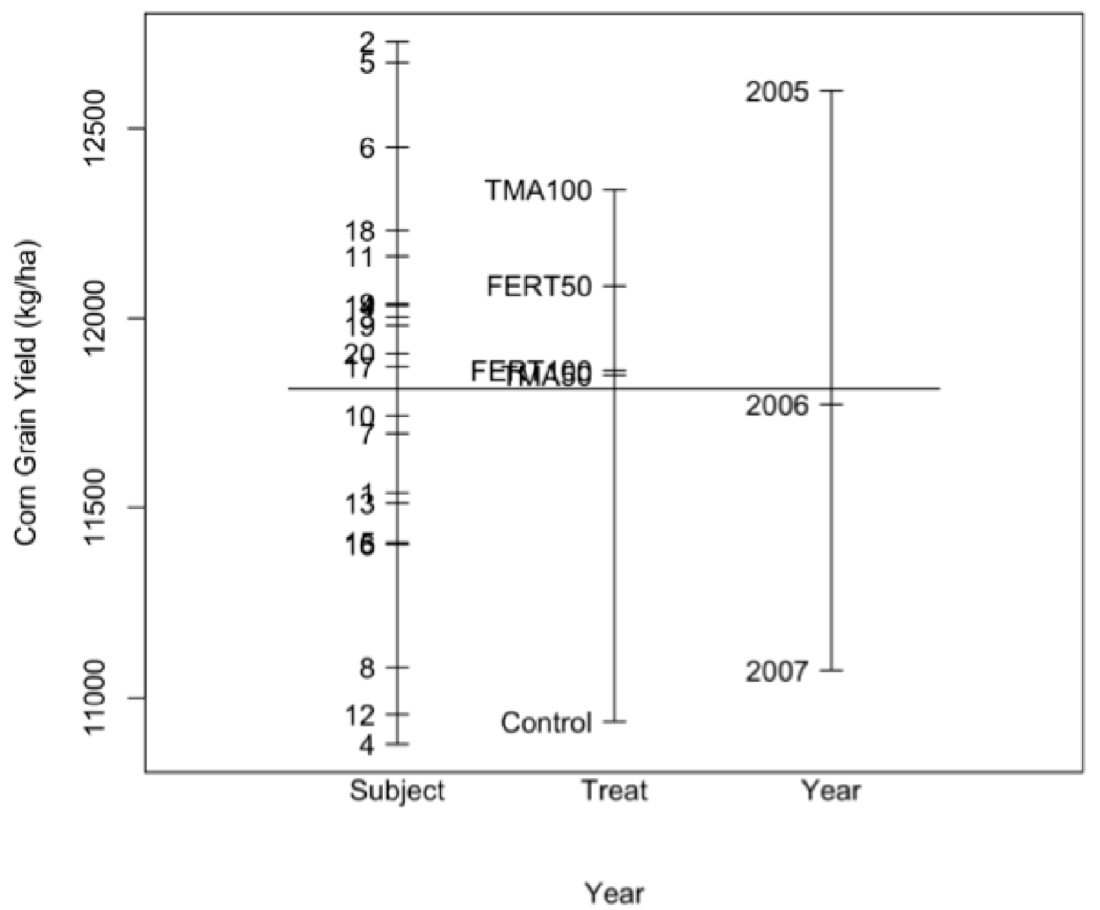
Figure 1. Plot of means for corn grain yield for the factors subject (plot (subject), averaged over year), treatment (Treat, averaged over year and block), and year (averaged over treatment and block).